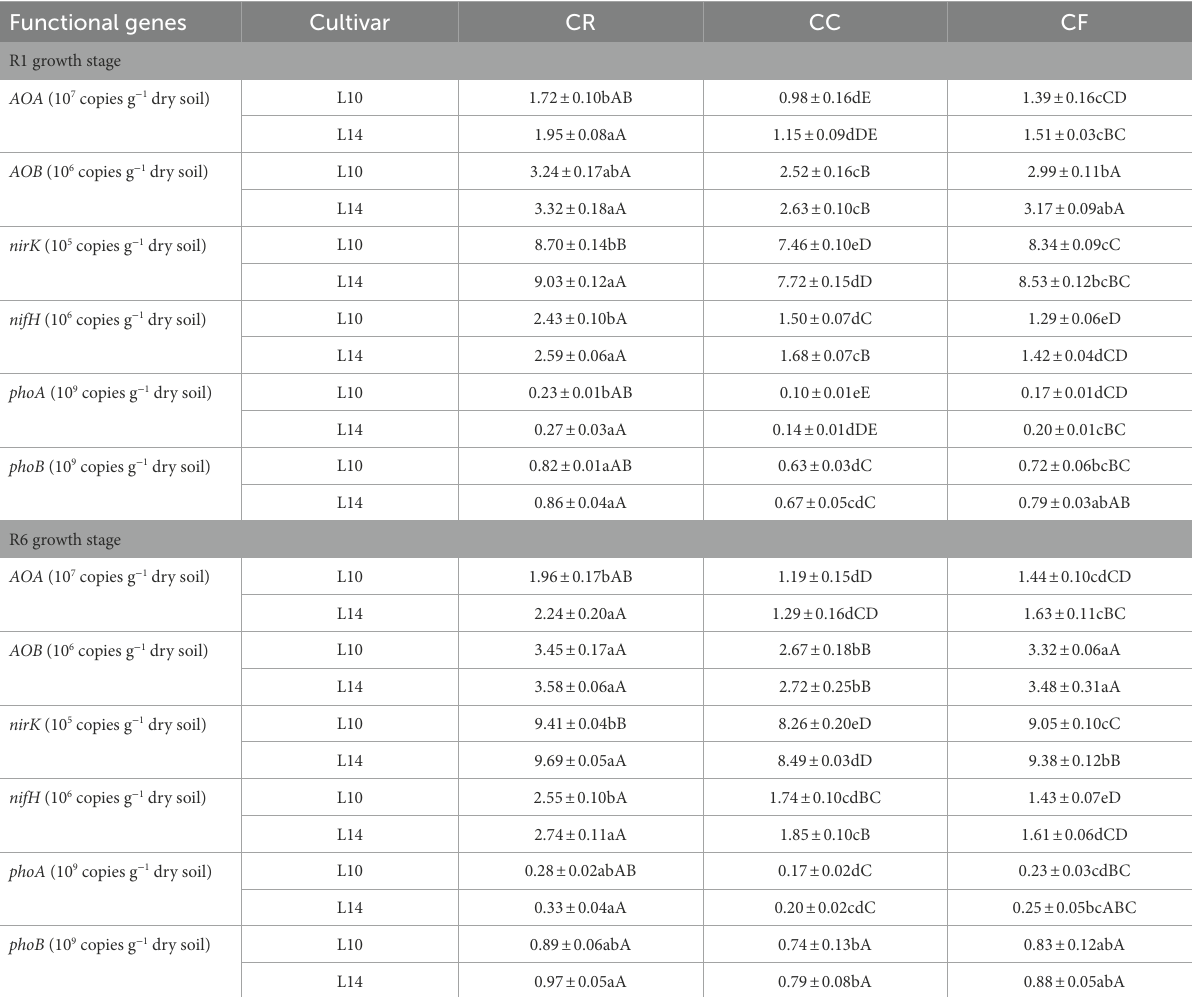
TABLE 3 Effects of crop rotation and continuous cropping on copy numbers of soil nitrogen and phosphorus functional genes. Functional